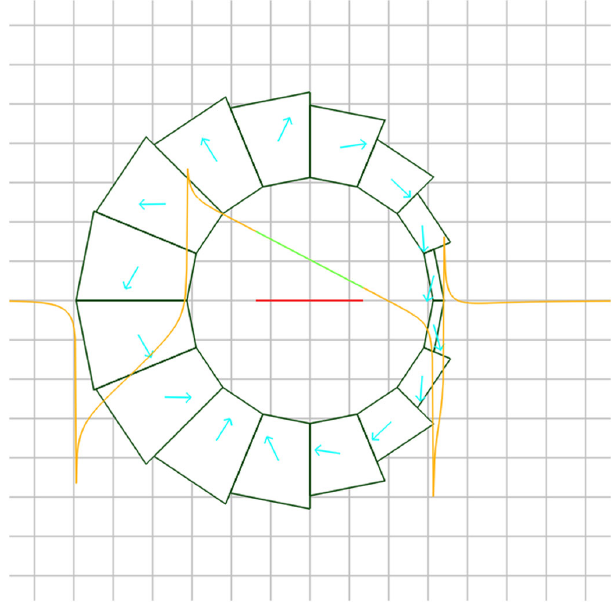
FIG. 5. Cross section of the BD magnet.